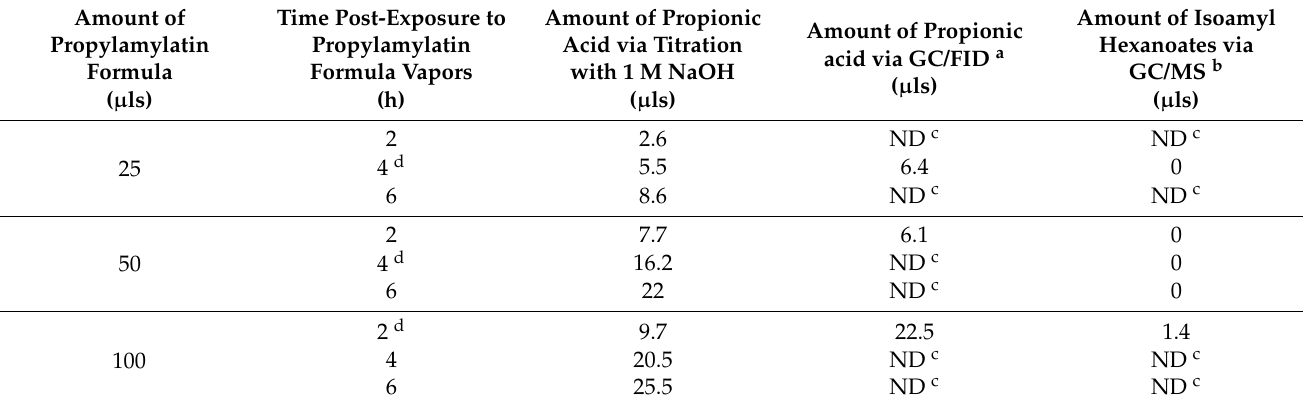
Table 1. The amount of dissolved propionic acid and isoamyl hexanoates in tissue culture medium incubated in the presence of volatilized Propylamylatin formula resulting from different liquid volumes at 37 ◦